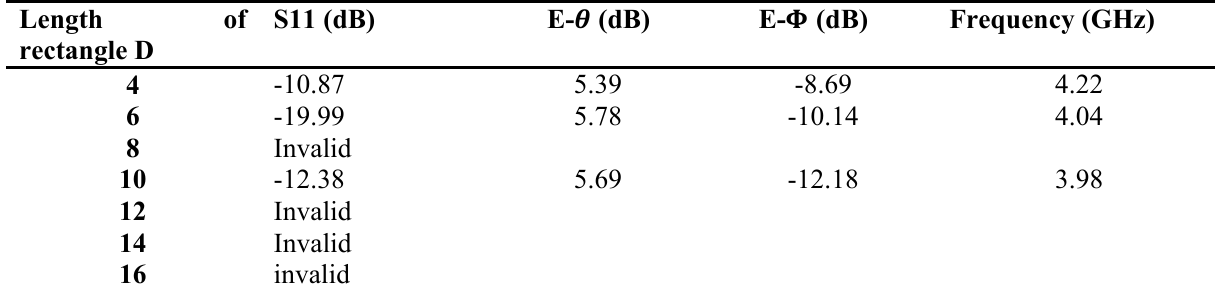
Table 4. Results of fourth parametric study Length